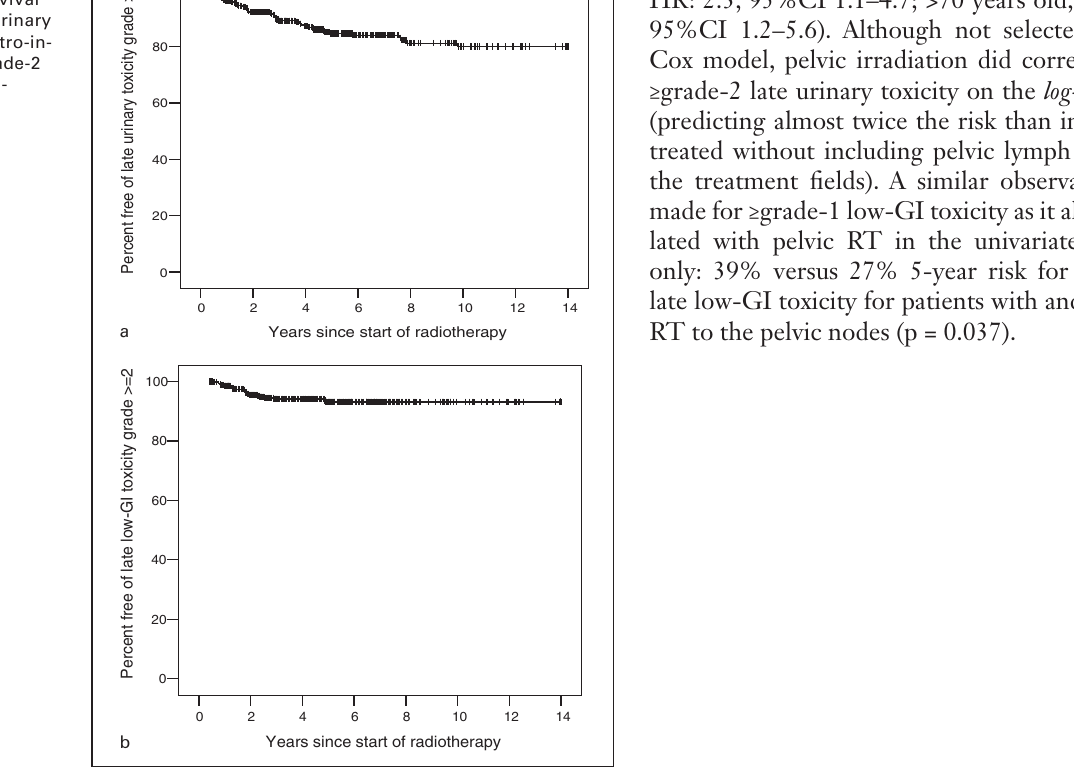
(a) and low gastro-in- testinal (b) ≥grade-2 toxicity (Kaplan- Meier).